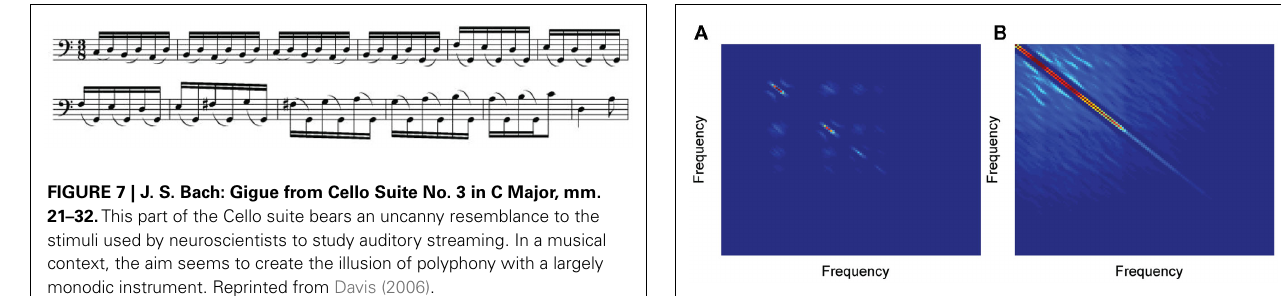
FIGURE 8 |An illustration of the coherence model ofASA applied to music. The coherence matrices (see text, A Coherence Model of ASA Applied to Musical Analysis) are displayed for excerpts of two pieces by György Ligeti, Lontano [ (A) , Sound Example S5 in Supplementary Material] and the San Francisco Polyphony [ (B) , Sound Example S6 in Supplementary Material]. Coherence has been averaged for the first 20s of each piece, and the displays are organized by frequency channels. As the qualitative difference between panels suggest, the perceptual organization experienced in the two cases is radically different (even though the composition of the orchestra stays basically the